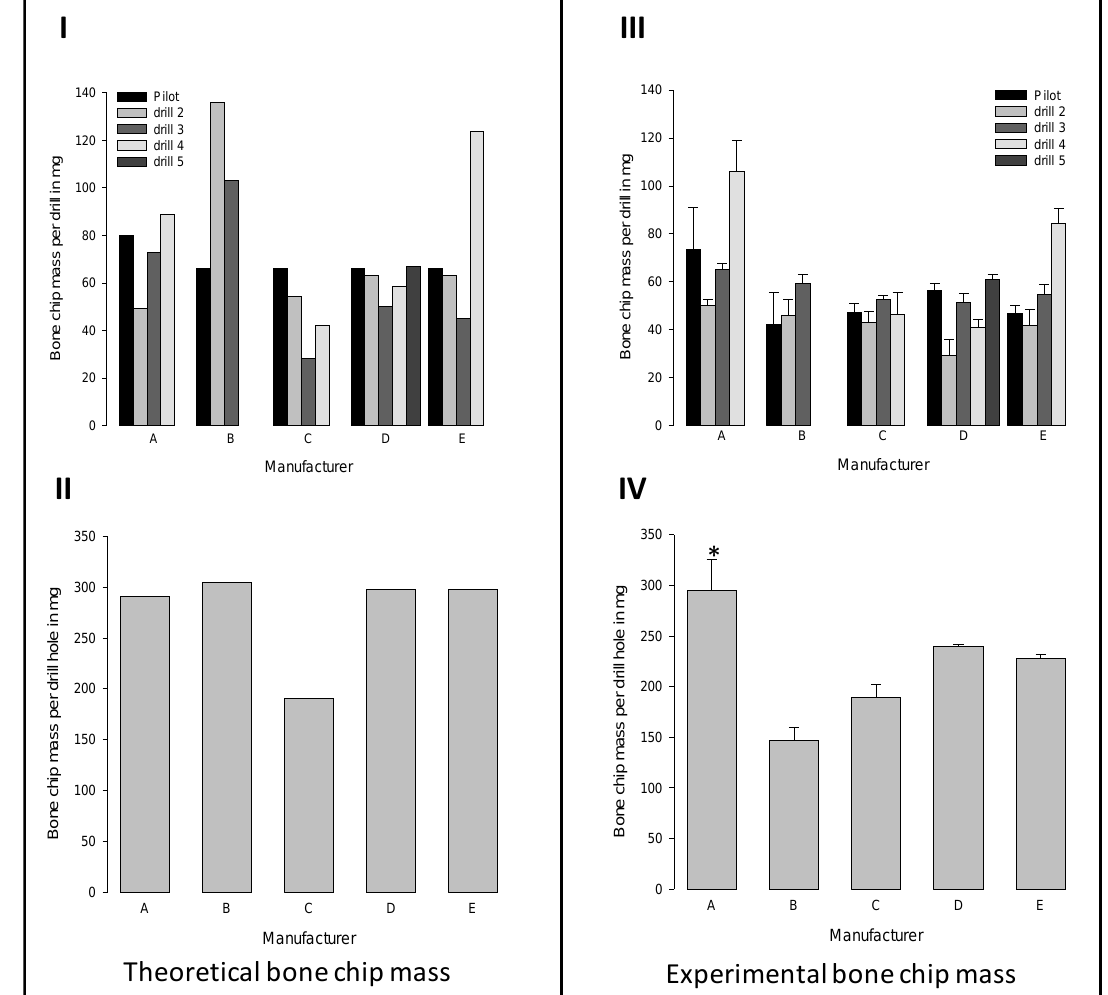
Figure 7. Comparison of ( I , II ) theoretically expected and ( III , IV ) experimentally produced bone chip mass. The upper row presents the results for each drilling tool of the five commercial implant drill sets ( I , III ) The lower row shows the total bone chip masses produced with a whole drill set ( II , IV ). (mean ± SEM; n = 3). * significant difference compared to all other drill sets (Kruskal-Wallis One Way Analysis of Variance on Ranks with subsequent Student-Newman-Keuls test, p ≤ 0.05).